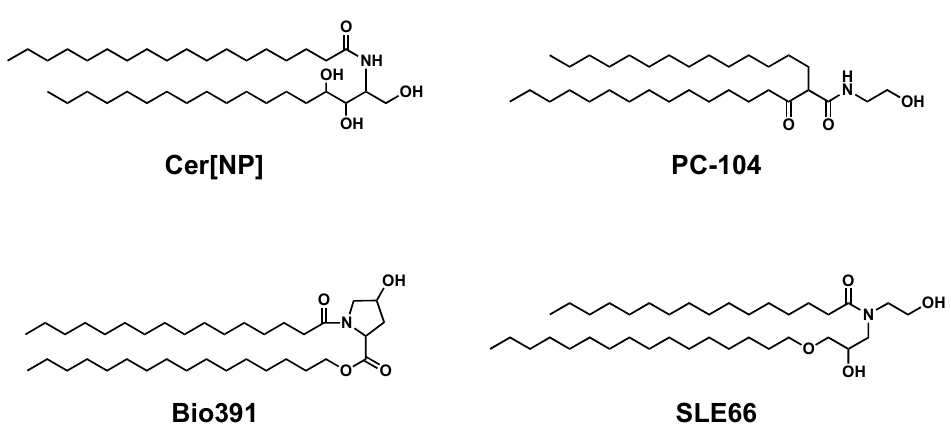
Figure 6. Chemical structure of natural and skin-identical ceramide (Cer[NP]) and synthetic pseudo-ceramides. These structures are cited from the literature [111,113].